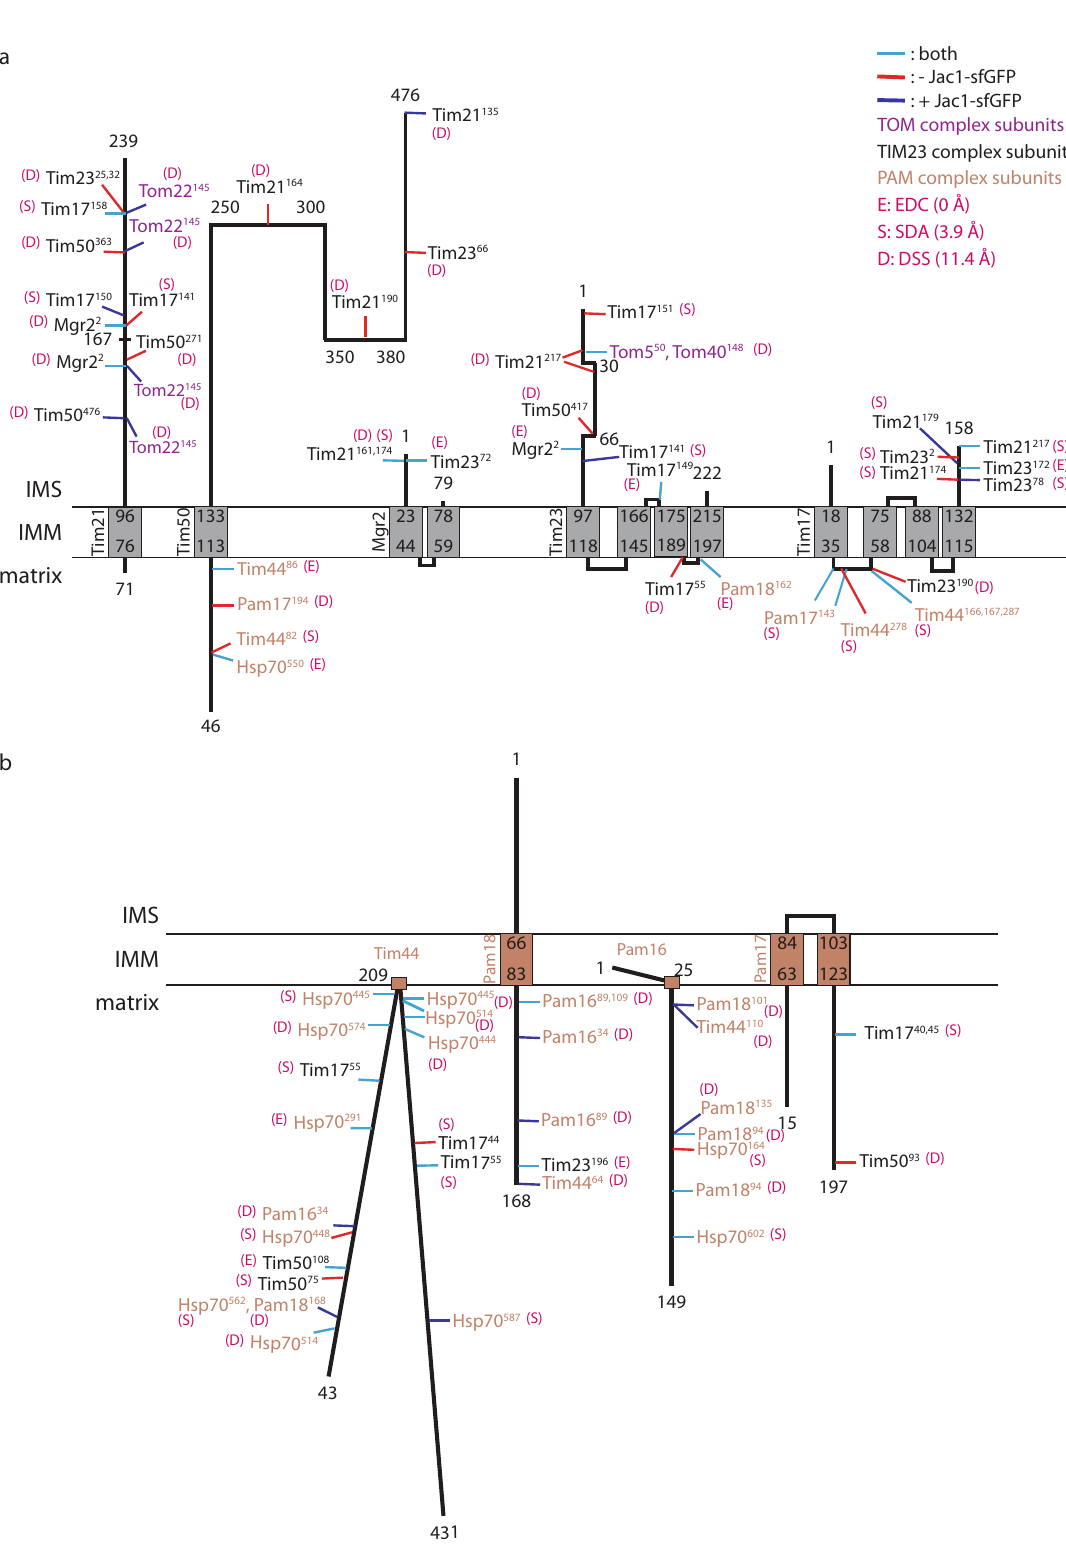
Fig. 3 Analyses of cross-links in the TOM-TIM23 supercomplex. Schematic representation of inter-protein cross-links identi fi ed for a TIM23 complex subunits and b PAM complex subunits by LC-MS/MS analysis following cross-linking of the isolated complex with DSS (11.4 Å spacer), EDC (0 Å spacer), and SDA (3.9 Å spacer). The cross-links can be found in Supplementary Data 1, approach 1, and Supplementary Data 2. Numbers indicate amino acid residue. IMS: intermembrane space, IMM: inner mitochondrial